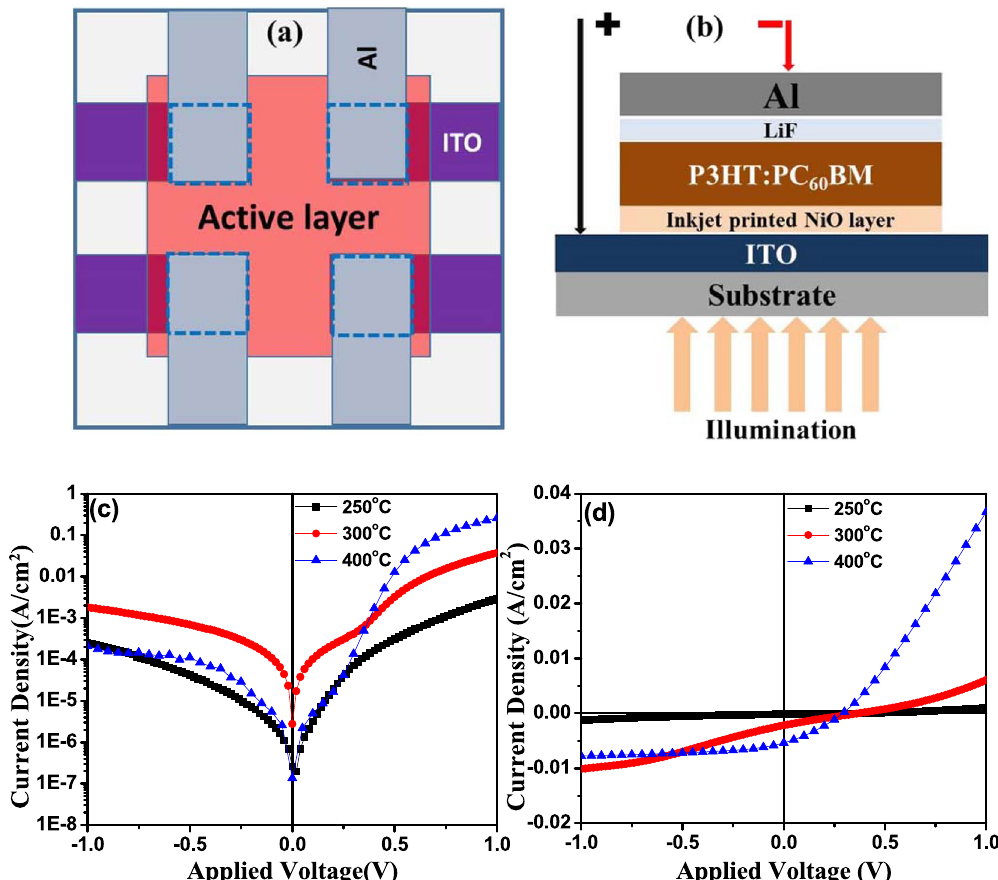
Figure 7. ( a ) The geometry of the electrode and ( b ) configuration of the OSC device (dotted square represent the device area(3 × 3mm 2 ) while the glass substrate was of size 1.0 inch 2 ); ( c ) Dark and ( d ) light J-V characteristics of P3HT:PC 60 BM organic solar cell devices fabricated on inkjet printed NiO hole transport layers, heat treated at various